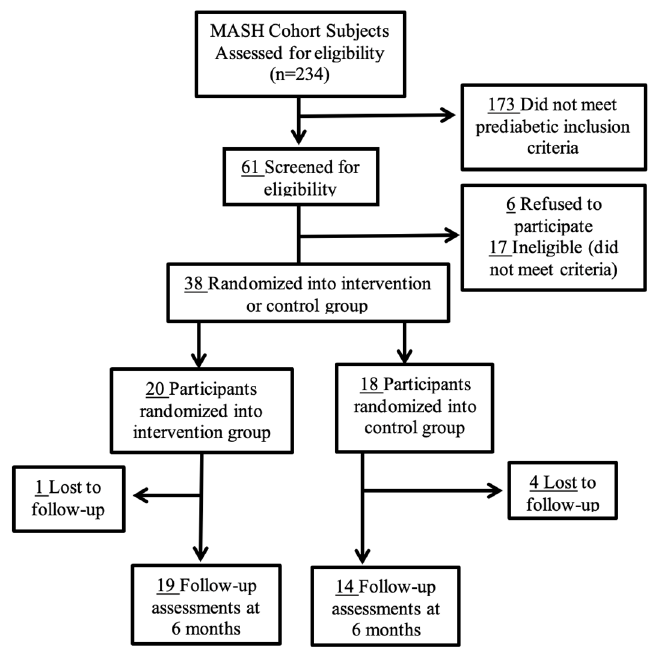
Figure 1. CONSORT